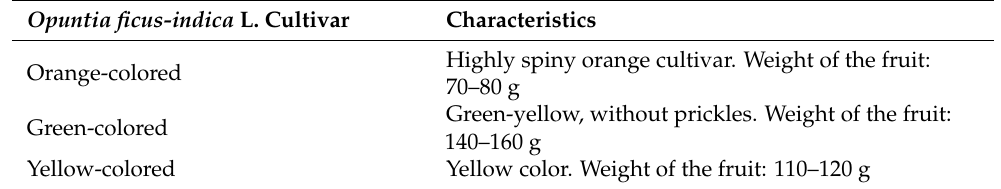
Table 1. Characteristics of the fruits of the different prickly pear cultivars collected from the Souk Ahras area, Northeast Algeria.